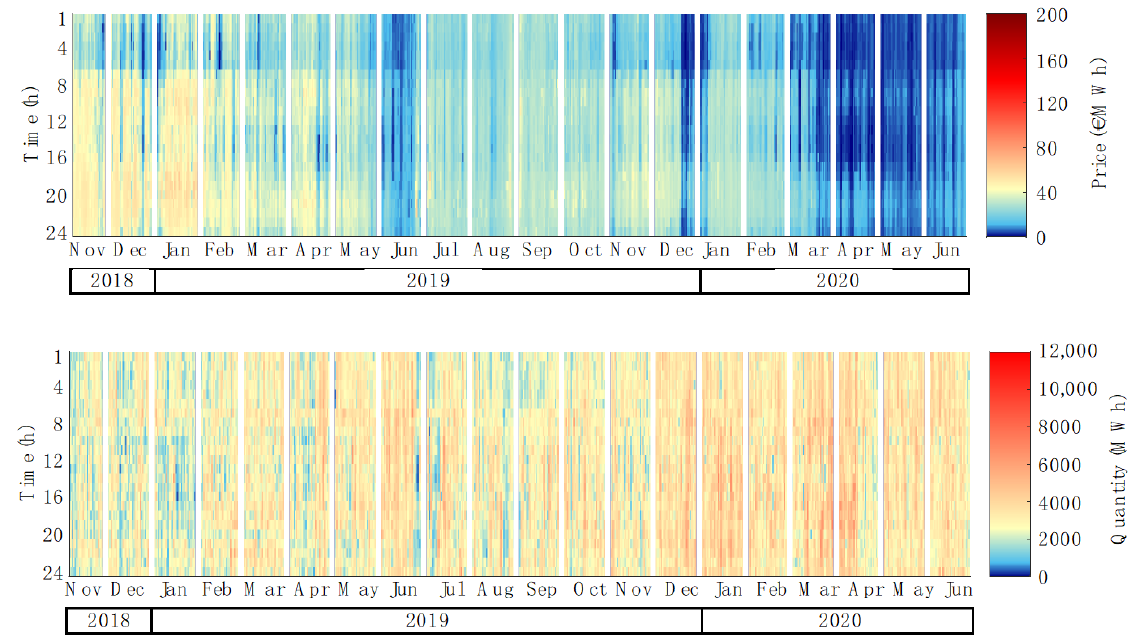
Figure A3. Heatmap of awarded downward bids on the Italian ASM (MSD ex-ante + MB) in terms of weighted average price (chart above ) and summed quantity (chart below ) with hourly resolution in the timeframe November 2018 to June 2020.